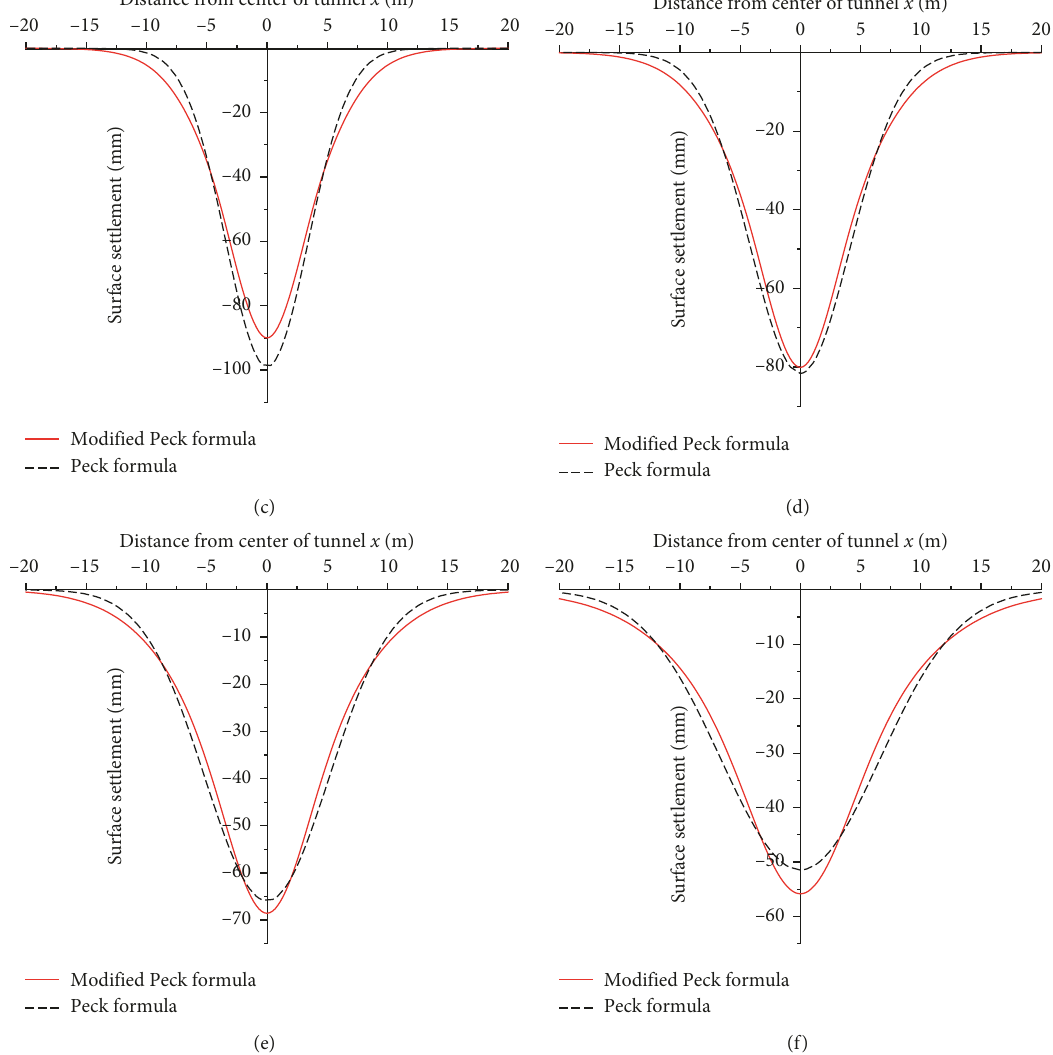
Figure 8: Comparison of surface settlement curves with different internal friction angles: (a) φ � 0 ° ; (b) φ � 10 ° ; (c) φ � 20 ° ; (d) φ � 30 ° ; (e) φ � 40 ° ; (f) φ � 50 °